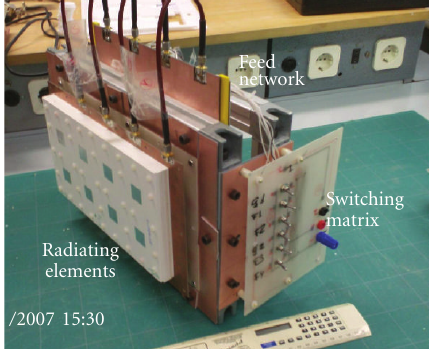
Figure 13: Photograph of the complete antenna.